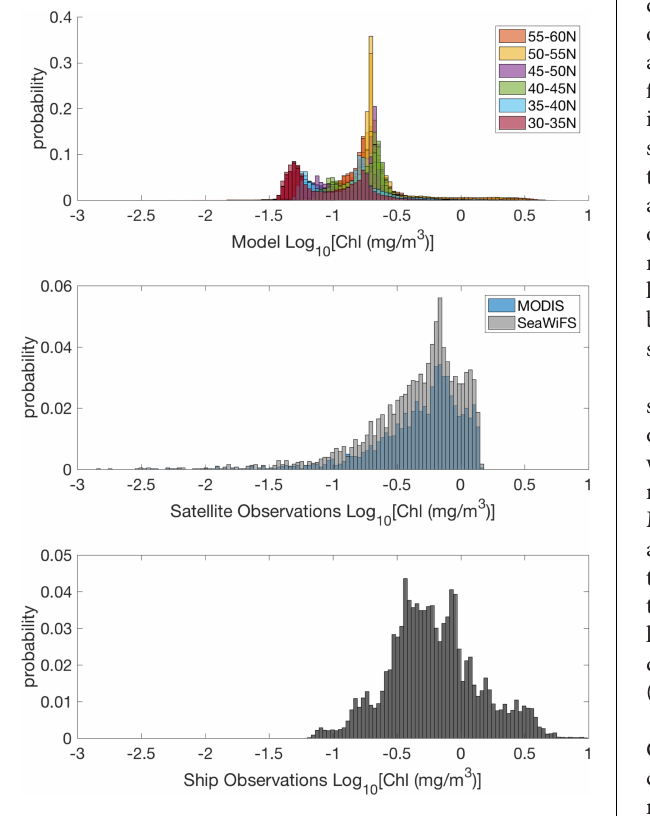
FIGURE 6 | Normalized histograms of Log 10 Chlorophyll a concentration from the CESM model (top, colored by latitudinal band), satellites (middle), and ship observations